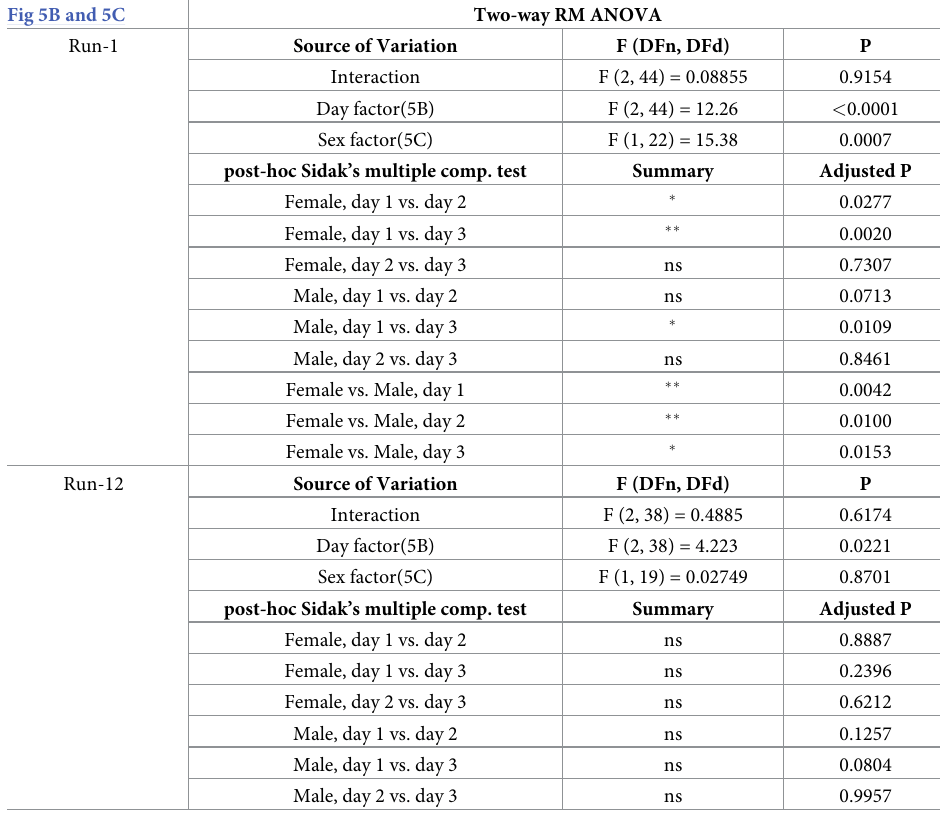
Table 6. Statistical analysis of data shown in Fig 5B and 5C for place reversal, cohort A, Run-1, and Run-2.